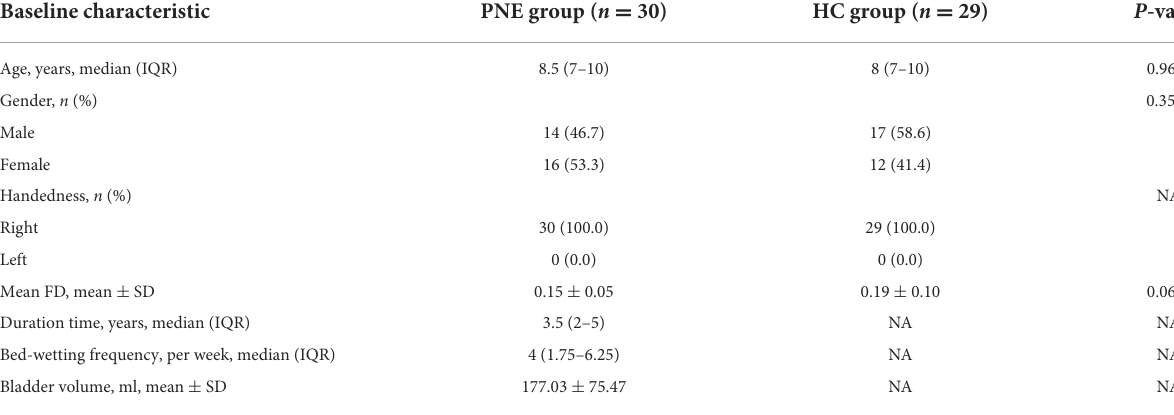
TABLE 1 Demographic and clinical data for PNE and HC